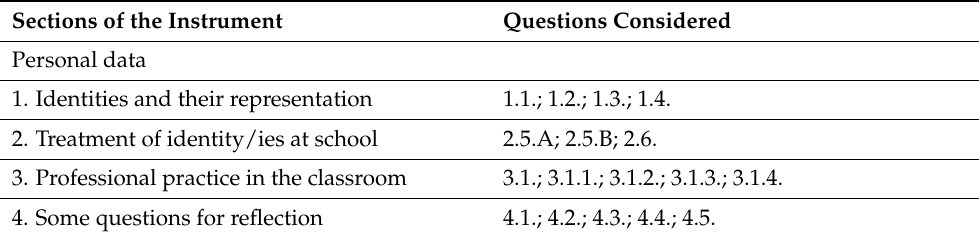
Table 2. Sections of the